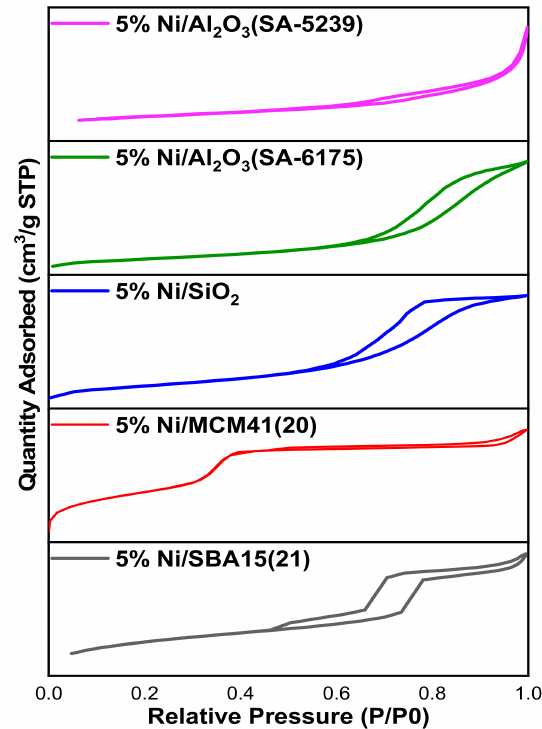
Figure 1. N 2 Adsorption-desorption isotherms for the Ni-supported